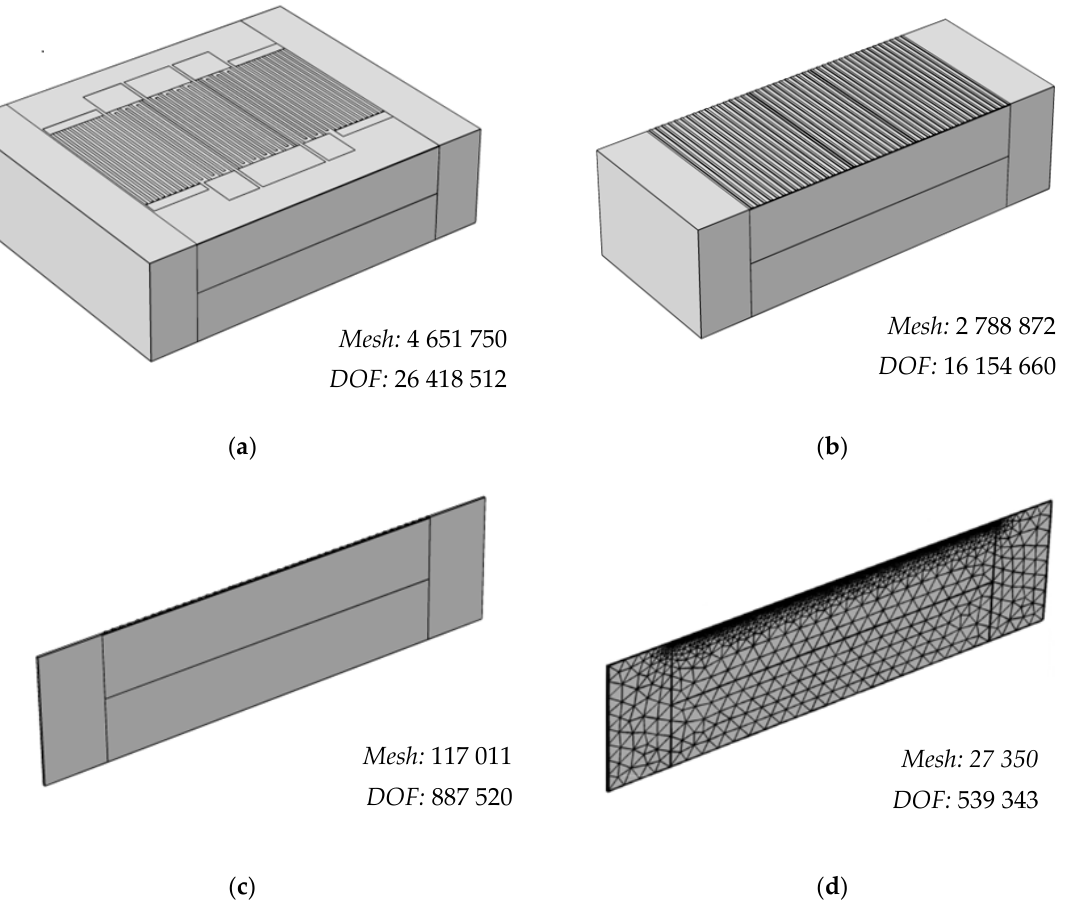
Figure 4. Optimization of the design number of the mesh elements and DOF: ( a ) 3-D DMS filter geometry with bus bars and full aperture; ( b ) filter geometry with full aperture and without bus bars; ( c ) transfer to a small-aperture variant; ( d ) mesh optimization due to SAW physics features.